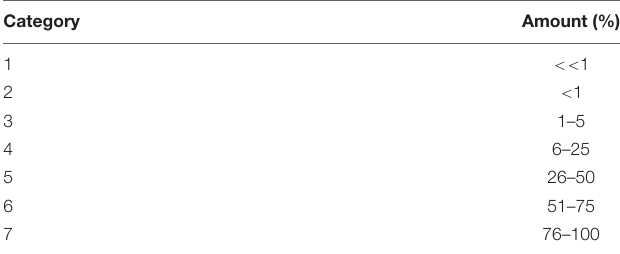
TABLE 2 | Classification of the relative abundance of organism groups into categories.